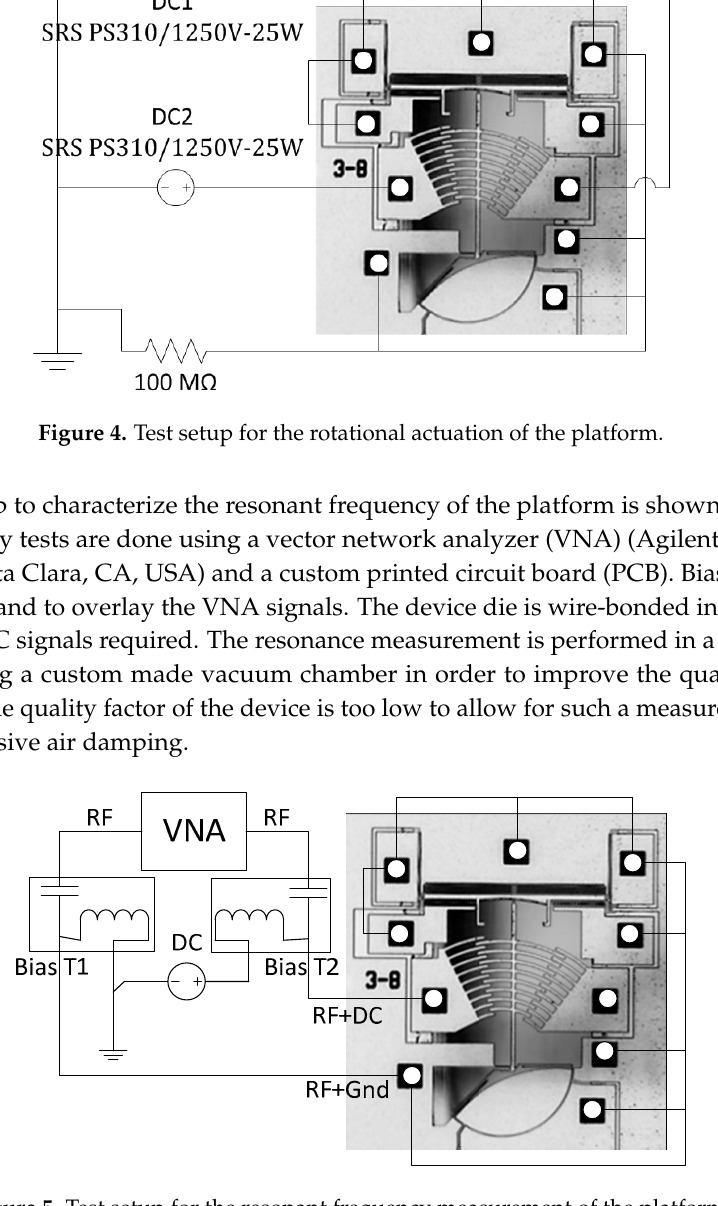
Figure 5. Test setup for the resonant frequency measurement of the platform.